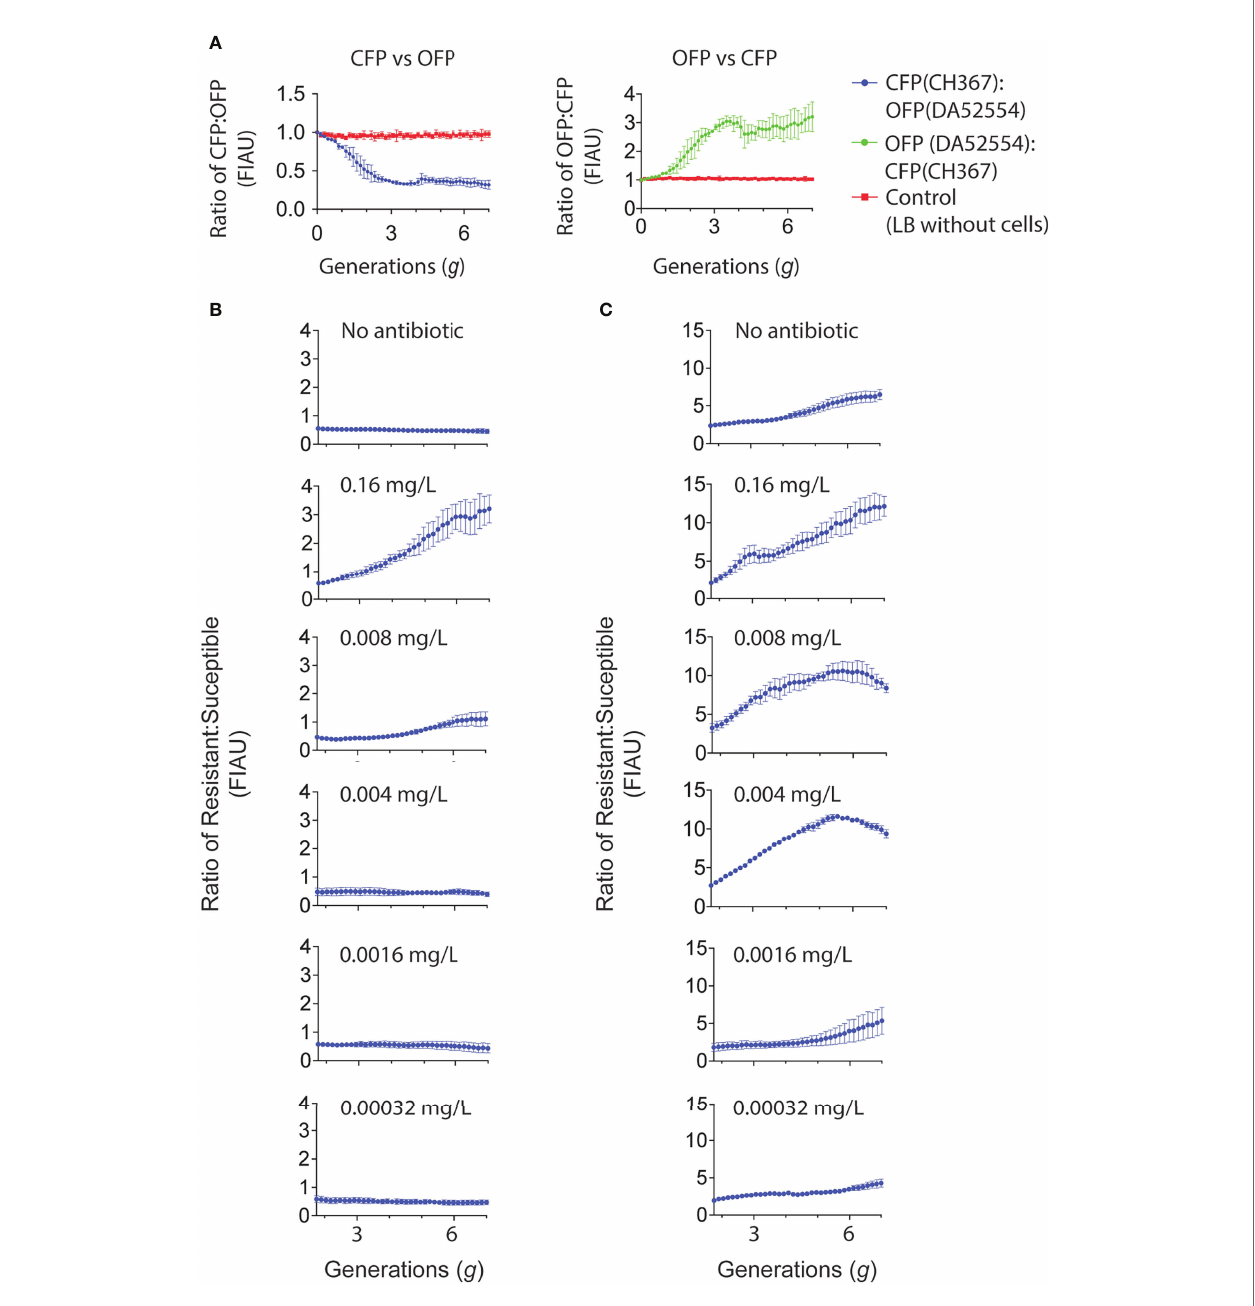
FIGURE 5 | Cultivation of mixed strain bio fi lms exposed to low concentrations of cipro fl oxacin. (A) Direct competitions between E. coli MG1655 labeled with CFP (CH367) and OFP (DA52554) in mixed strain bio fi lms. The strains were mixed 1:1 and bio fi lm growth studied using time-lapse confocal microscopy over a 16 h period. The mean ratio of each of the fl uorescence observed from three independent competition experiments as normalized fl uorescent intensity arbitrary units (FIAU) are presented for both graphs in (A – C) Direct competition of mixed strain bio fi lms of wild type E. coli MG1655 strains (CH367, CFP; DA52554, OFP; as presented in A) and E. coli MG1655 with the gyrA (S83L) cipro fl oxacin resistance mutation to account for strain and fl uorescence marker differences (CH368, CFP + gyrA (S83L); DA66208, OFP + gyrA (S83L)). The cipro fl oxacin susceptible and resistant strains were mixed at 1:1 ratio. (B) The mean of 15 independent competitions for the resistant strain (CH368) vs. susceptible strain (DA52554) without cipro fl oxacin supplemented in growth medium (LB only) is shown, whilst for all remaining graphs the mean of three independent competitions is presented. (C) The mean of 18 independent competitions for the resistant strain (DA66208) vs. susceptible strain (CH367) without cipro fl oxacin supplemented in growth medium (LB only) is shown. For the cipro fl oxacin concentrations 0.016, 0.0016, and 0.00032 mg/L the mean of four independent experiments is shown. The remaining graphs shows the mean of three independent competitions. Standard errors of the mean are indicated for all graphs in (A – C)